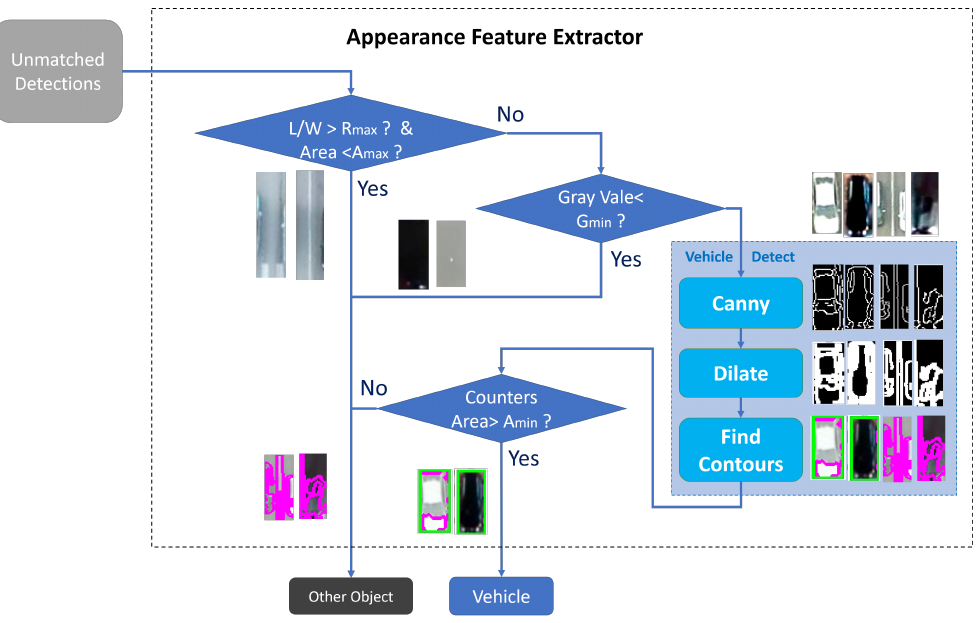
Figure 7. Flowchart for using the appearance feature